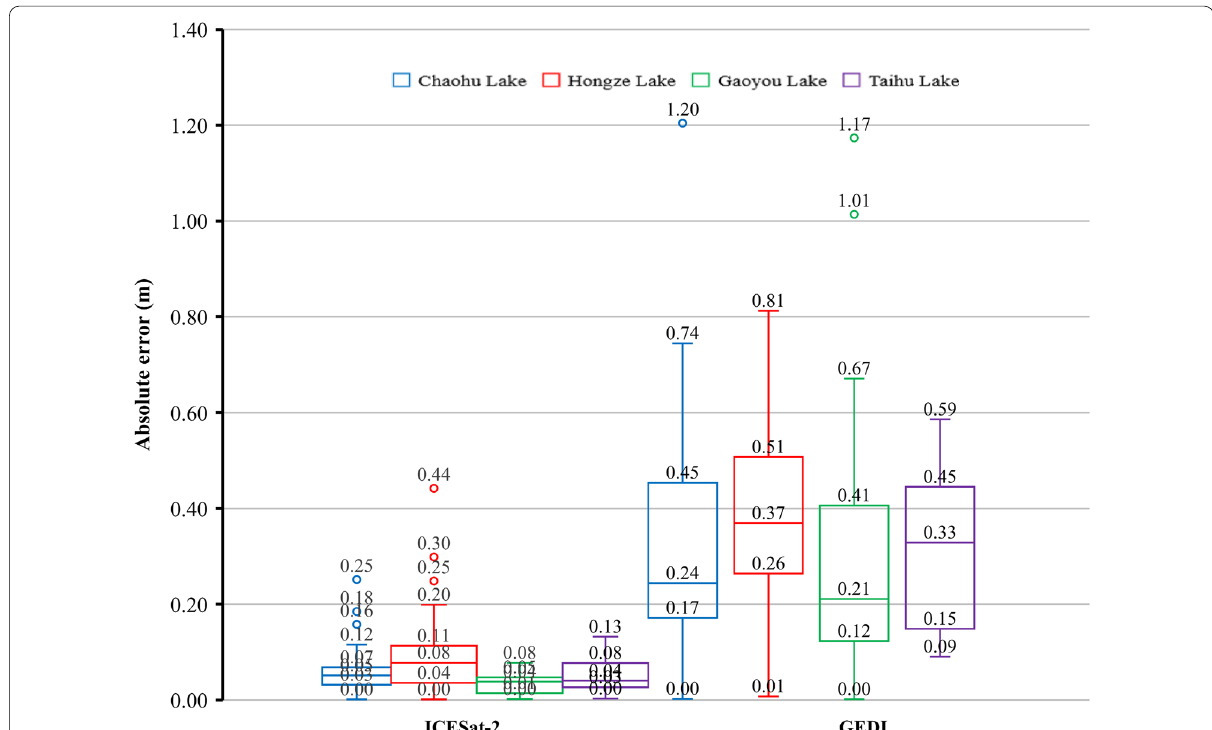
Fig. 5 Boxplot of MAE between ICESat-2 and GEDI observations and in situ water levels for the four lakes (the horizontal line numbers from bottom to top indicate the lower edge, first quantile, median, third quantile and upper edge in turn, and the discrete circulars represent the outliers)